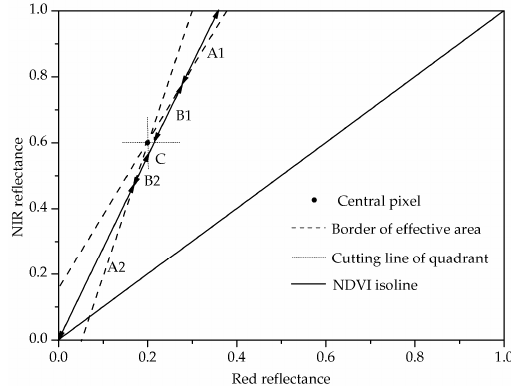
Figure 8. Schematic diagram of the effective area within certain NDVI accuracy and the determination of neighboring pixels based on which the accurate aerosol corrected NDVI can be derived.